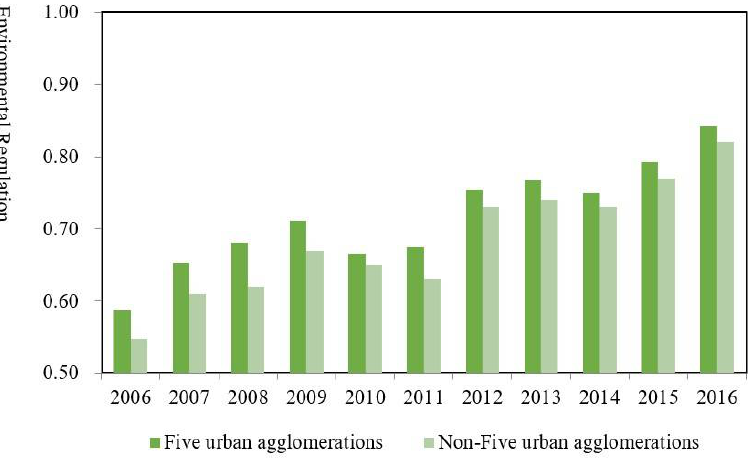
Figure 2. Changes in environmental regulation intensity of five major urban agglomerations and non-five major urban agglomerations.